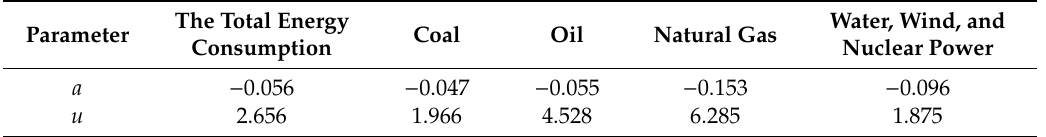
Table 2. Parameter estimation of GM (1,1).